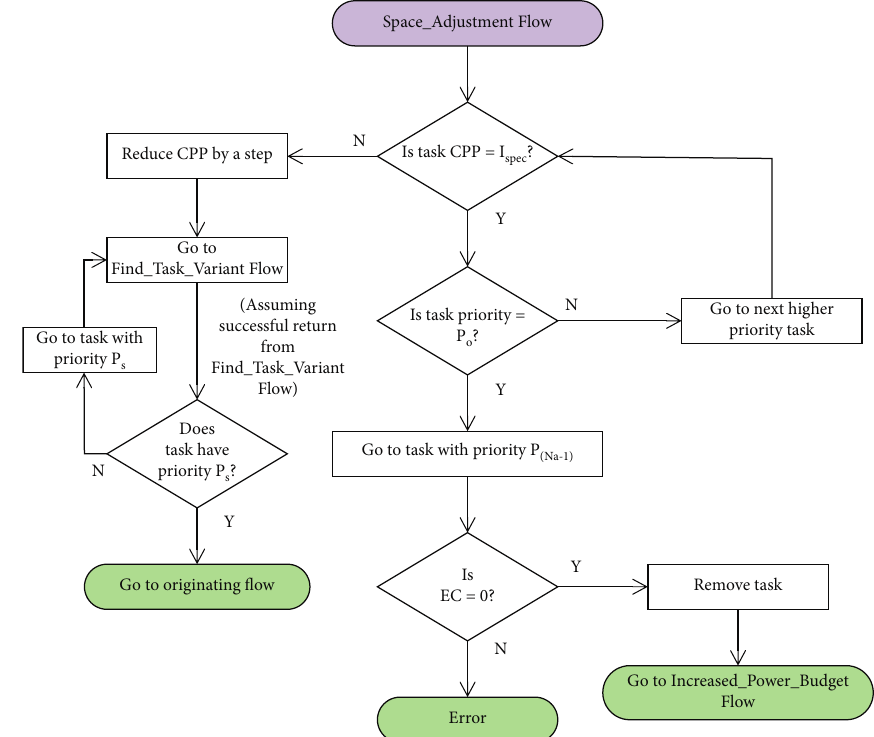
Figure 8: Space_Adjustment flow of